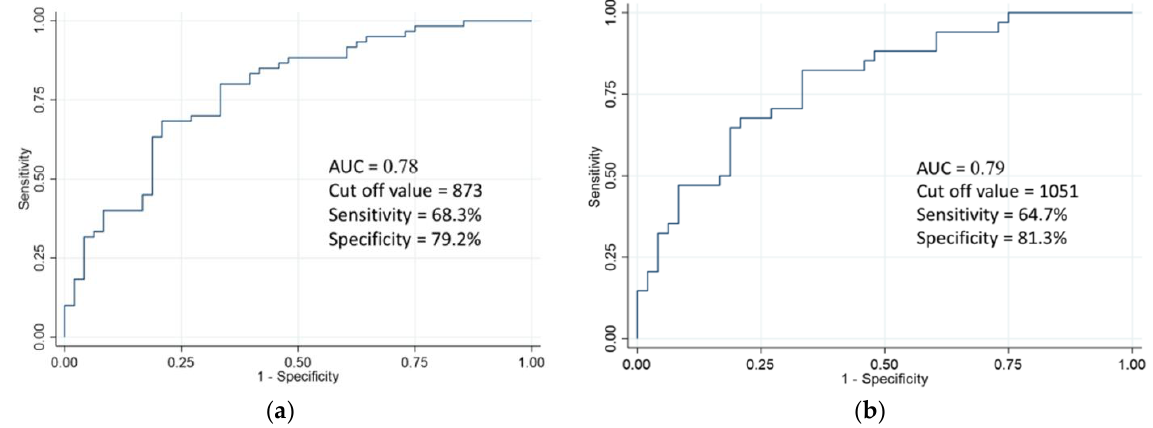
Figure 2. Receiver-operating characteristic (ROC) analysis of serum epiplakin expression levels ( a ) ROC analysis of serum epiplakin expression levels in patients with bladder cancer. The area under the ROC curve level was 0.78. The sensitivity and specificity were 68.3% and 79.2%, respectively, using a cut-off point of 873. ( b ) ROC analysis of serum epiplakin expression levels in patients with NMIBC. The area under the curve-ROC level for bladder cancer was 0.79. The sensitivity and specificity were 64.7% and 81.3%, respectively, using a cut-off point of 1051.